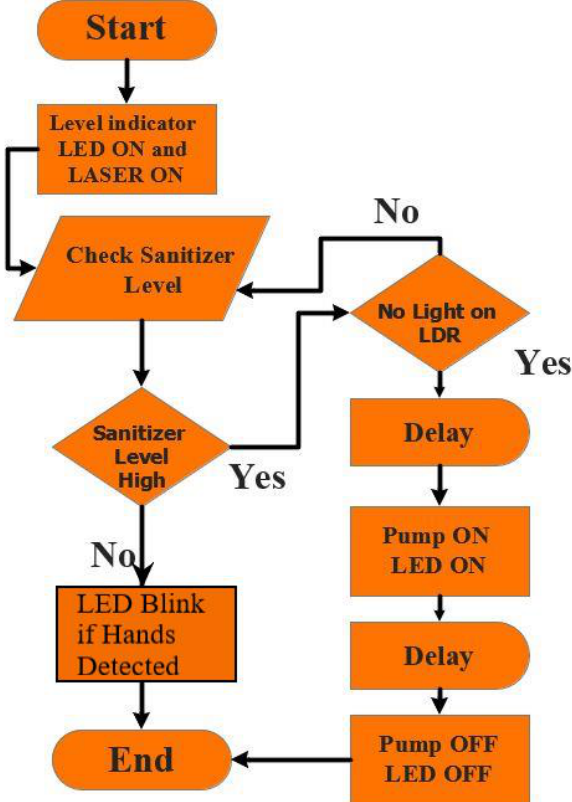
Figure 3. Flowchart of working pattern of the fabricated sanitizer